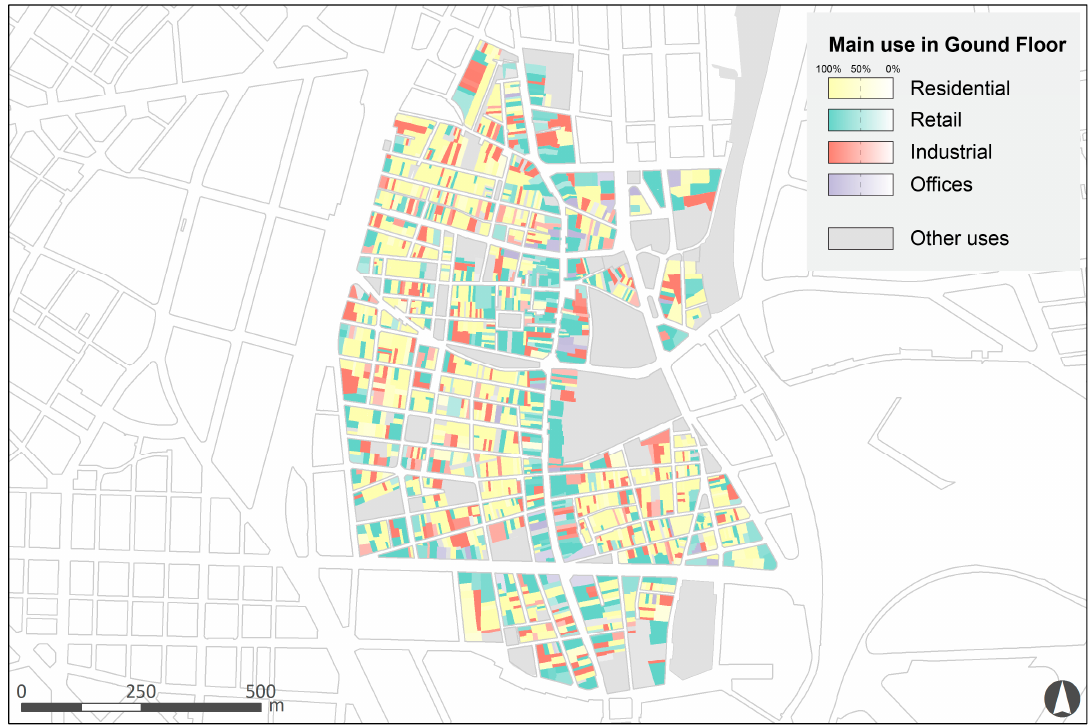
Figure 20. Map of parcels colored by main use at street level.